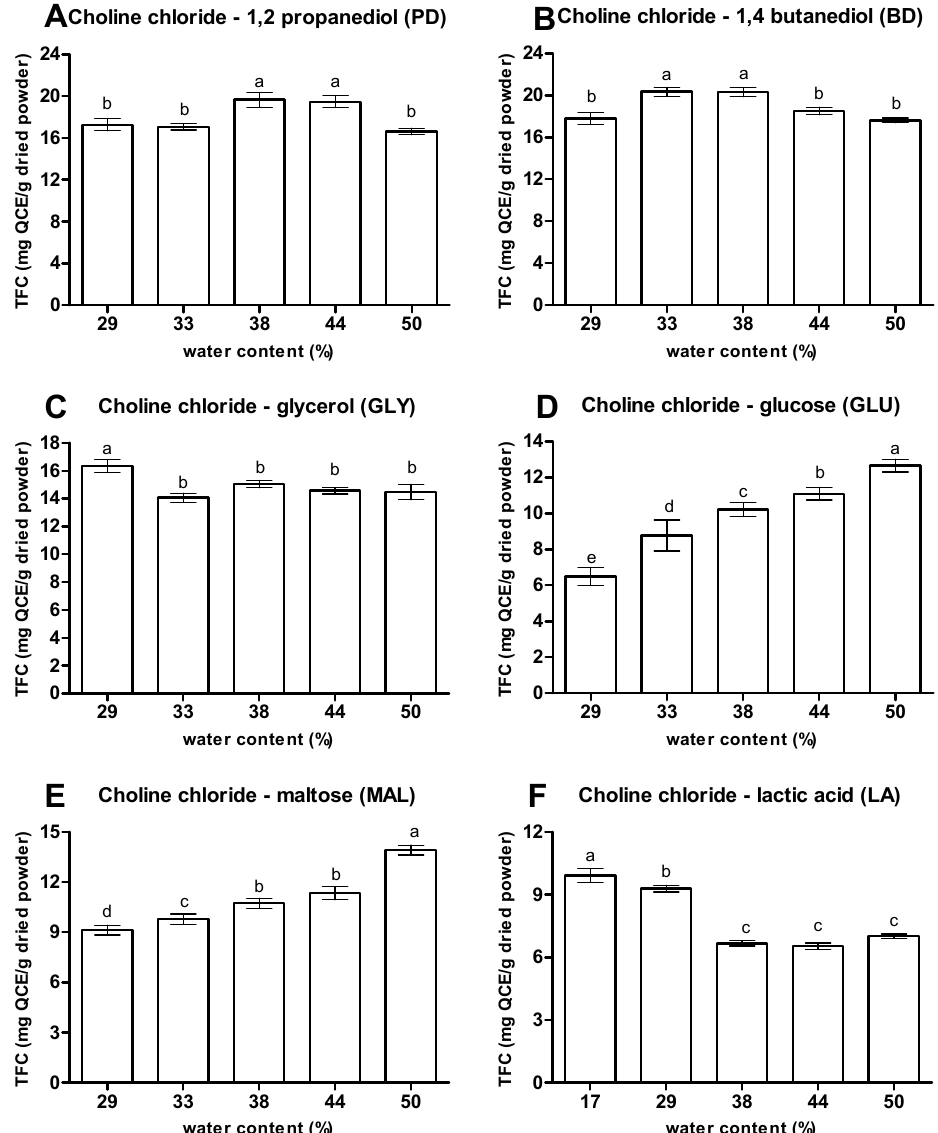
Figure 5. Effect of different water contents of NaDES. ( A ) Choline chloride—1,2 propanediol, ( B ) Choline chloride—1,4 butanediol, ( C ) Choline chloride—glycerol, ( D ) Choline chloride—glucose, ( E ) Choline chloride—maltose and ( F ) Choline chloride—lactic acid. Values are presented as mean ± standard deviation of three measurements. Value marked with different letters indicate comparison among water contents in NaDES which are statistically significant differences at p < 0.05.